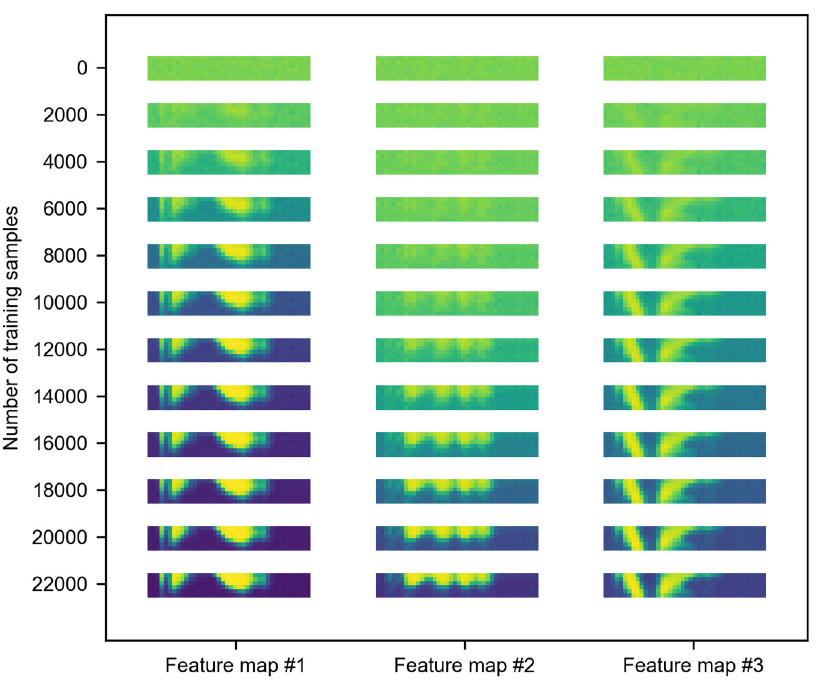
Fig 7. The visualization of evolving receptive fields in the training process. There is no special feature before training since the weights are initialized randomly. As the training proceeded, the features are gradually learned. Finally, the learned features are distinct from each other due to the effect of lateral